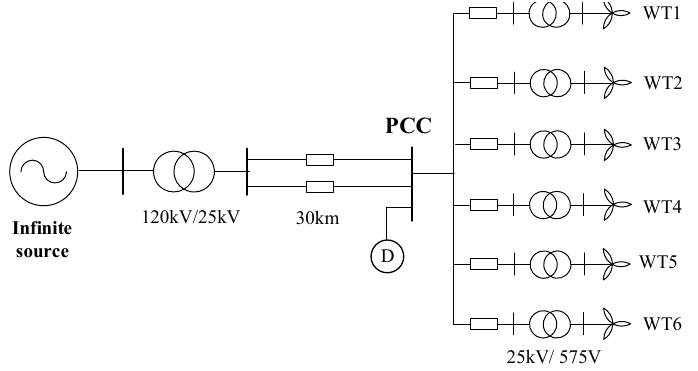
Figure 3. A SMIB system with DFIG wind farm interconnection. Small signal stability analysis for the SMIB system was carried out, and its eigenvalues and participation factors are shown in Table 1. In Table 1, x 1 ~ x 4 are the inner state variables of the rotor side converter controller; v DC is the capacitor DC voltage; x 5 ~ x 7 are the inner state variables of the grid side converter controller, and P is the participation factor. Table 1. Eigenvalues and dominant participation